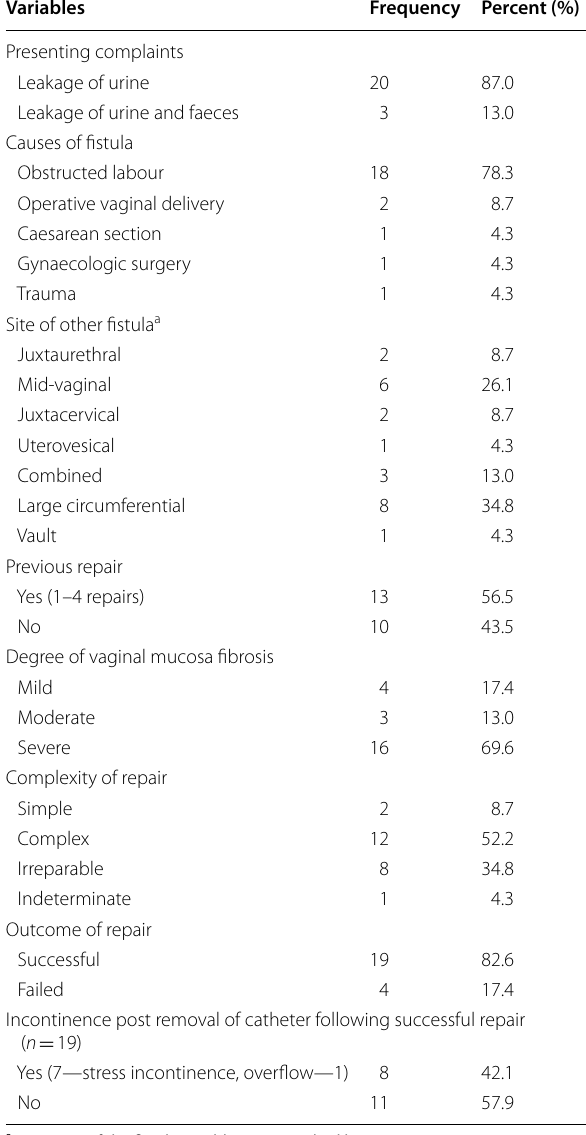
Table 2 Clinical presentation and fistula characteristics of